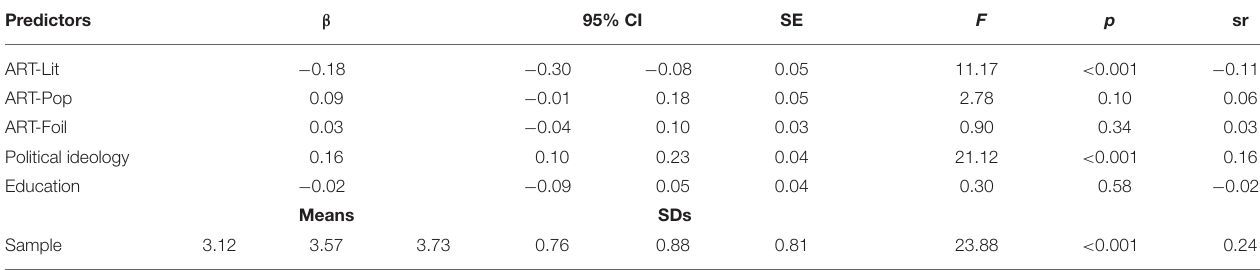
TABLE 1 | Multiple regression results with discreteness as criterion (Study 1).